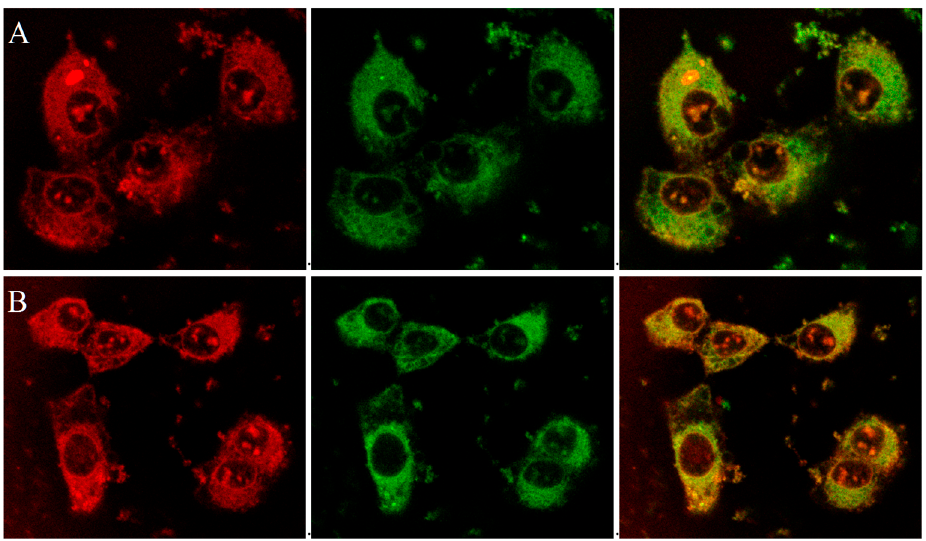
Figure 2. Confocal fluorescence microscopy on live DU145 cells incubated ( A ) with P-TPP-DOX (0.5 µ M DOX concentration) or ( B ) with P-TPP-DOX/P-TPP-CQ (0.5 µ M DOX, 1.25 µ M CQ) for 1 h and 100 nM MitoTracker ® Green FM for 15 min: (left) DOX (red channel, λ ex = 561 nm, λ em = 570–650 nm); (middle) MitoTracker ® Green FM (green channel, λ ex = 488 nm, λ em = 500–550 nm); and (right) overlay image showing co-localization of green and red fluorescence in yellow.